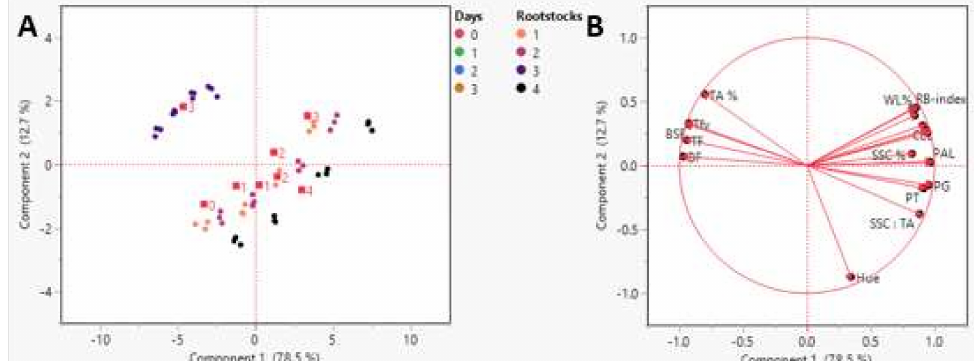
Figure 7. Principal component analysis (PCA) representing shelf life duration in days and four rootstocks of Superior Seedless grapes, plotted with the contribution of each parameter on the four PCA axes ( A ) and all of the physiological and biochemical parameters measured in bunches during the storage period ( B ). Principal component analysis (PCA) variable